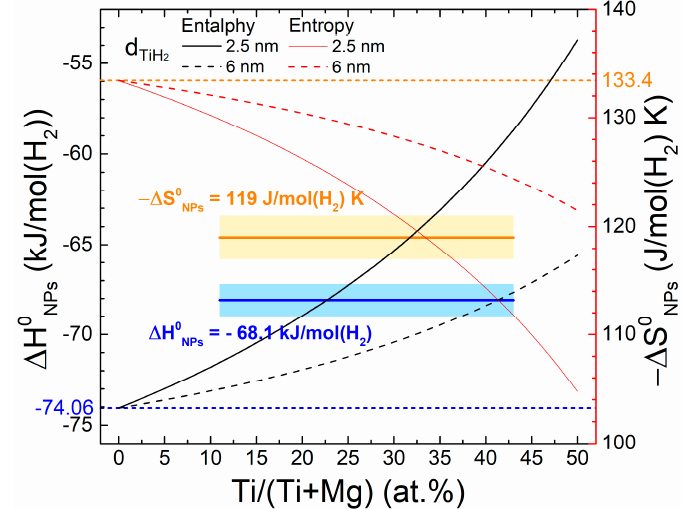
Figure 7. MgH 2 formation enthalpy ∆ H 0 (black lines) and the opposite of formation entropy ∆ S 0 NPs (red lines) in composite MgH 2 –TiH 2 NPs as a function of Ti atomic percentage as predicted by Equation (12). Calculations are reported for two different TiH 2 grain sizes: 2 nm (solid lines) and 6 nm (dashed lines) using ∆ h int = 0.64 J/m 2 and ∆ s int = 0.9 × 10 − 3 J/m 2 · K. As a reference [9], the blue dashed line and the orange dashed line are the bulk MgH formation enthalpy and entropy, respectively. Experimental values for NPs, as in [8], are also displayed with error bands. The explored range of compositions is the one determined considering only MgH 2 and TiH 2 phases, X Ti = 11, 20, 43 atom % instead of the correspondent nominal values ( X Ti = 6, 15, 30 atom %).